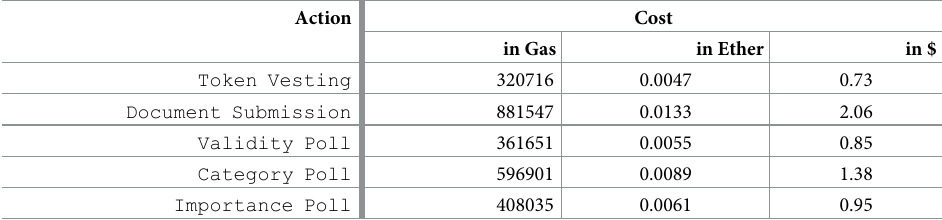
Table 1. The combined gas costs of all transactions required to complete each platform action, from the perspec- tive of a single user. The exchange rate of Ether to USD has been set to $155 and the gas price to 15Gwei (real values recorded on April 6th 2020). [58, 59].